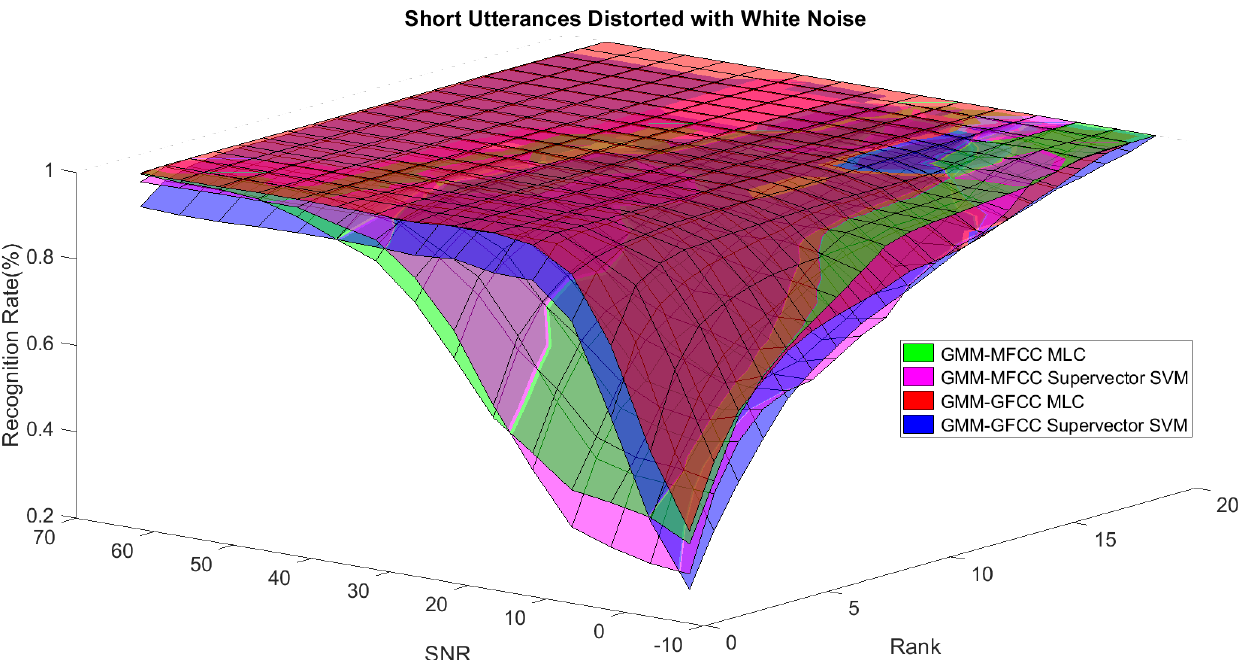
Figure 10. The 3D surface of the recognition rates for the four base classifiers on short utterances distorted with white noise.